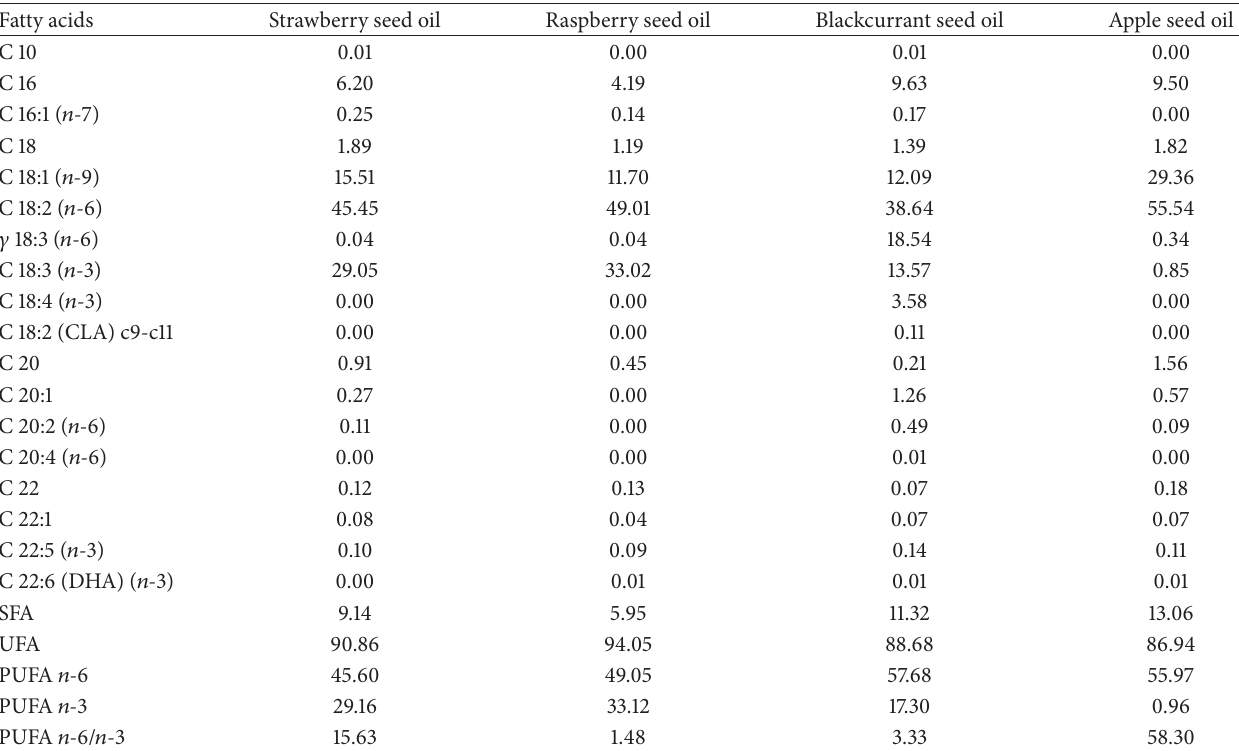
Table 2: Composition of fatty acids in oils from strawberry, raspberry, blackcurrant, and apple seeds (% of total fatty acids). Fatty